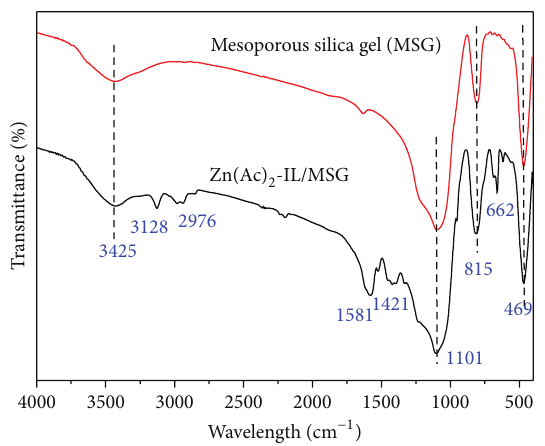
Figure 2: FT-IR of Zn(Ac) 2 -IL/MSG and MSG.